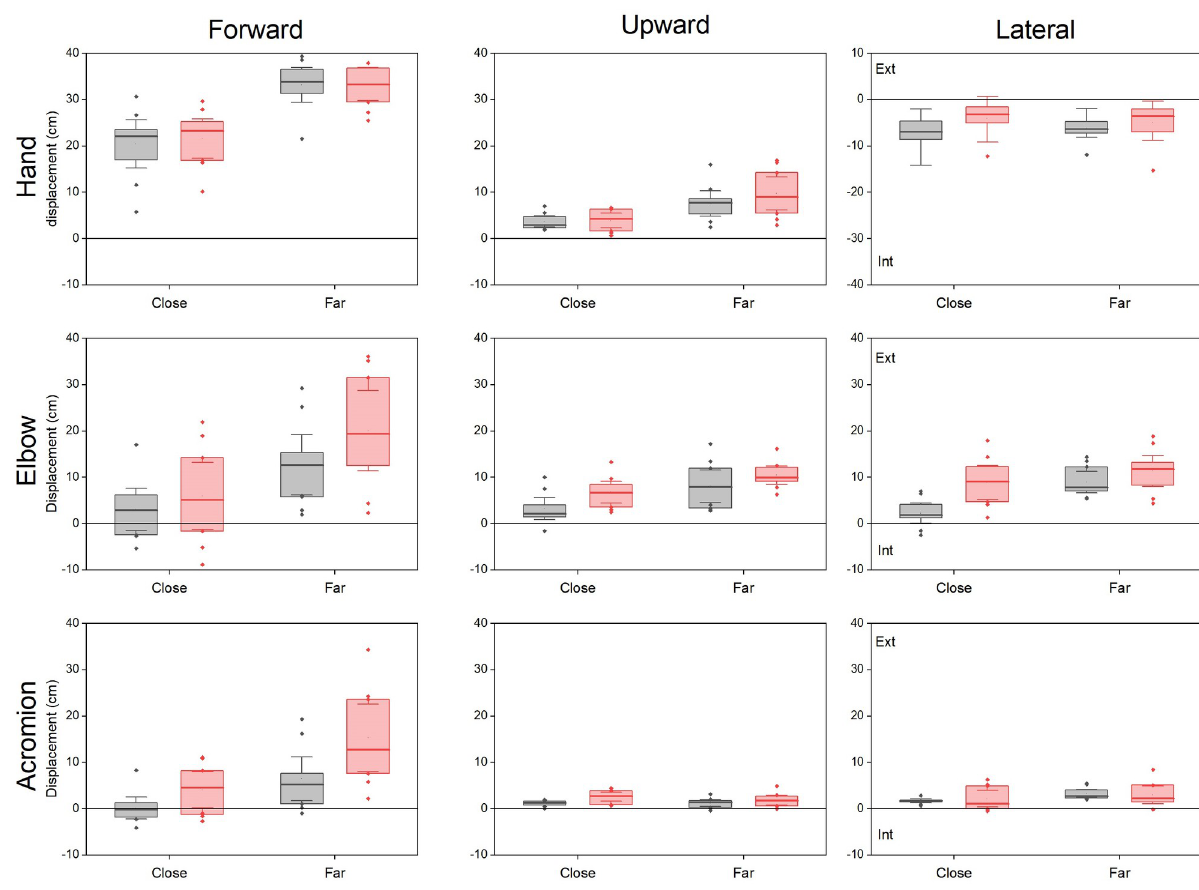
Fig 6. Comparison of the hand, elbow and acromion displacements in the three directions during reaching. Same legend as Fig 4. even more for the close one (1.39 ± 0.08, p = 0.02). However, the greater curvature on the pros- thetic side was only significant for the far distance (Wilcoxon, p = 0.02, d = 0.97). The displacement of the elbow in the forward, upward and lateral directions during reach- ing varied with conditions (Friedmann p = 0.0002, p = 0.0005 and p = 0.0002 respectively, Fig 6, middle panels). The elbow displacement in those three directions was significantly greater for the far target for both sides (Wilcoxon p = 0.005). Significant side differences were observed for the close target: on the prosthetic side, the displacement of the elbow was higher (6.9 ± 1.0 cm versus 3.16 ± 1.1 cm, Wilcoxon p = 0.02) and more external than on the non- amputated side (8.9 ± 1.6 cm and 2.3 ± 1.0 cm respectively, Wilcoxon p = 0.01). During reaching, the acromion moved mainly forward, with amounts which varied with side-distance conditions (Friedmann p < 0.0002, Fig 6, lower panels). The forward displace- ment of the acromion increased with target distance on both sides (Wilcoxon, p = 0.005, d = 1.55 and d = 1.68 for the non-amputated and prosthetic sides and was larger on the pros- thetic side for both targets. For the close target, the acromion remained stable on the non- amputated side (0.1 ± 1.0 cm) and moved forward (4.1 ± 1.7cm) on the prosthetic side (Wil- coxon p = 0.02, d = 0.98). For the far target, the forward displacement was smaller on the non- amputated (6.5 ± 2.1 cm) than on the prosthetic side (15.3 ± 3.2 cm, Wilcoxon, p = 0.005, d = 1.42).